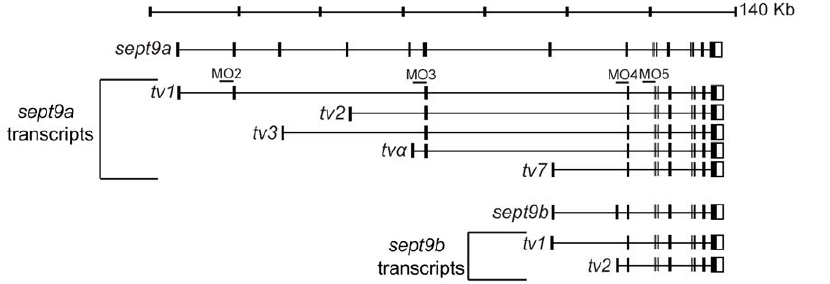
Figure 1. SEPT9 transcripts are conserved between zebrafish and mammals. Zebrafish possess two sept9 genes, sept9a and sept9b , that encode multiple mRNA transcripts homologous to mammalian transcripts. Zebrafish also express a transcript not currently found in mammals, sept9a_tv a . Sites of morpholino splice blockers are noted.